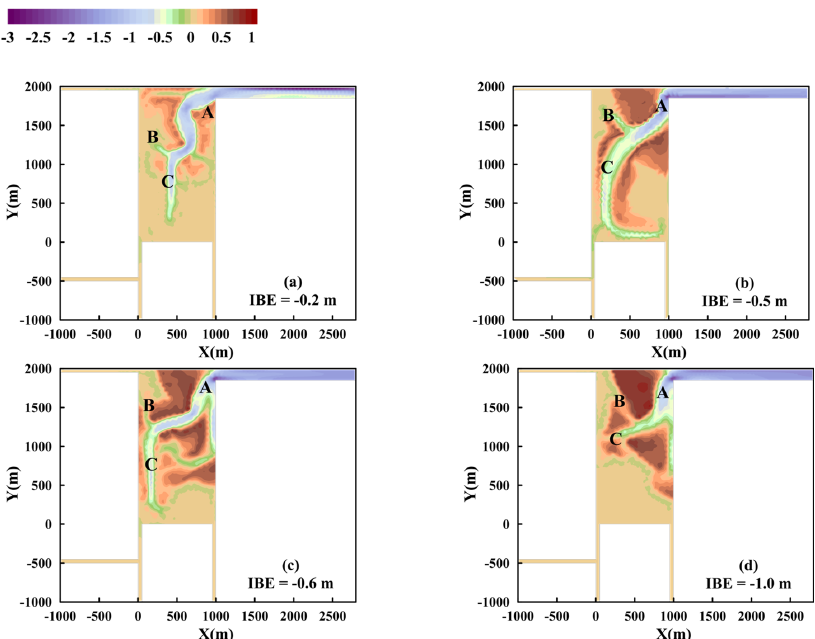
Figure 11. Terrain of ideal model of Qilihai Lagoon system with different IBEs, after 100 years, where the terrain elevation is ( a ) − 0.2 m, ( b ) − 0.5 m, ( c ) − 0.6 m and ( d ) − 1.0